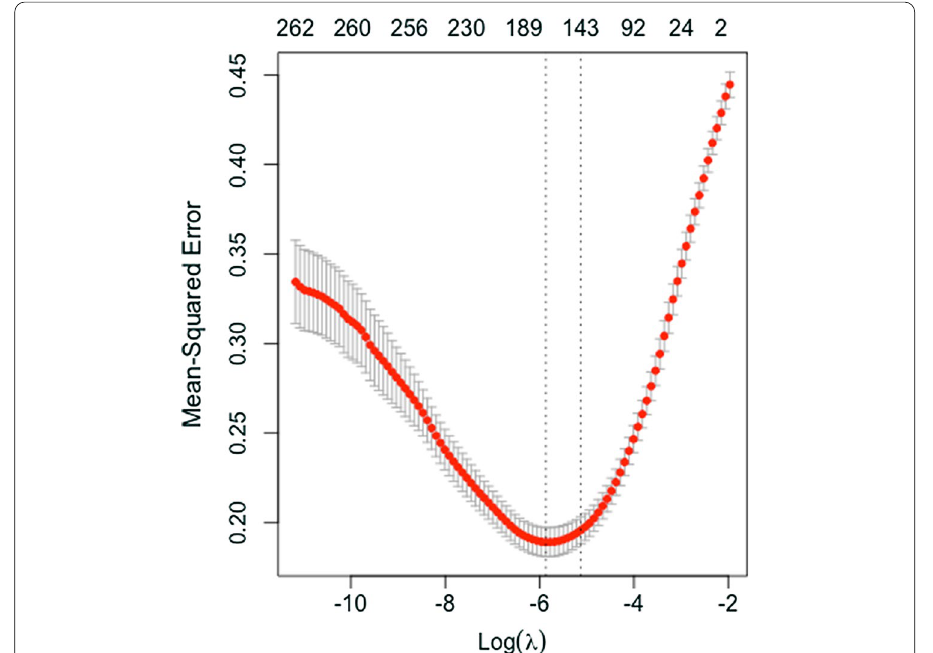
Fig. 5 Mean Squared Error for Attributes Prediction. This figure obtained two optimal values of lamda that leads to two distinct datasets